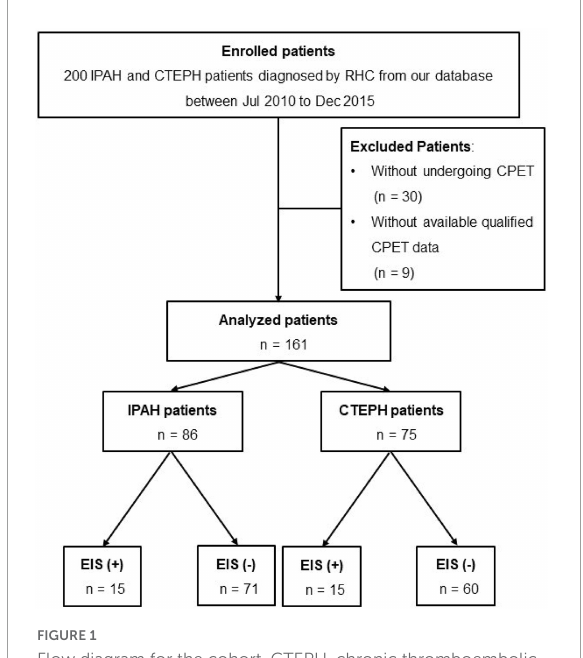
FIGURE1 Flow diagram for the cohort. CTEPH, chronic thromboembolic pulmonary hypertension; IPAH, idiopathic pulmonary arterial hypertension; RHC, right heart catheterization; CPET, cardiopulmonary exercise